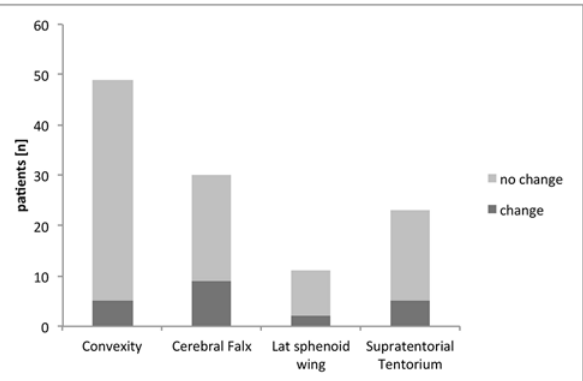
Fig 3. Distribution of change of treatment on ICU patients dependent on tumor localization. Patients were assigned to the indicated groups dependent on meningioma location. The occurrence of a change in ICU treatment did not differ between tumor location (Fisher ’ s exact test).